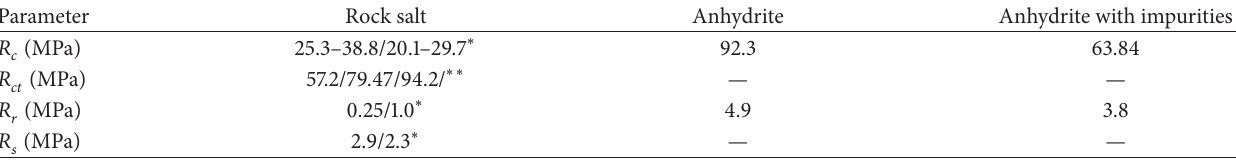
Table 3: Strength parameters of rock salt and anhydrite with rock salt impurities from the Polkowice-Sieroszowice mine [10]. Parameter Rock salt Anhydrite